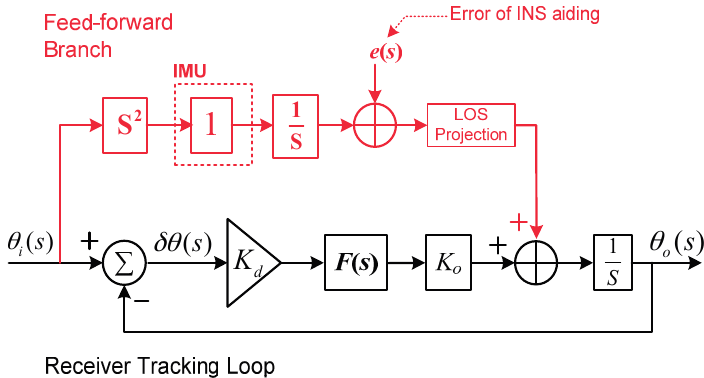
Figure 7. Mathematical model of GPS receiver tracking loop with INS